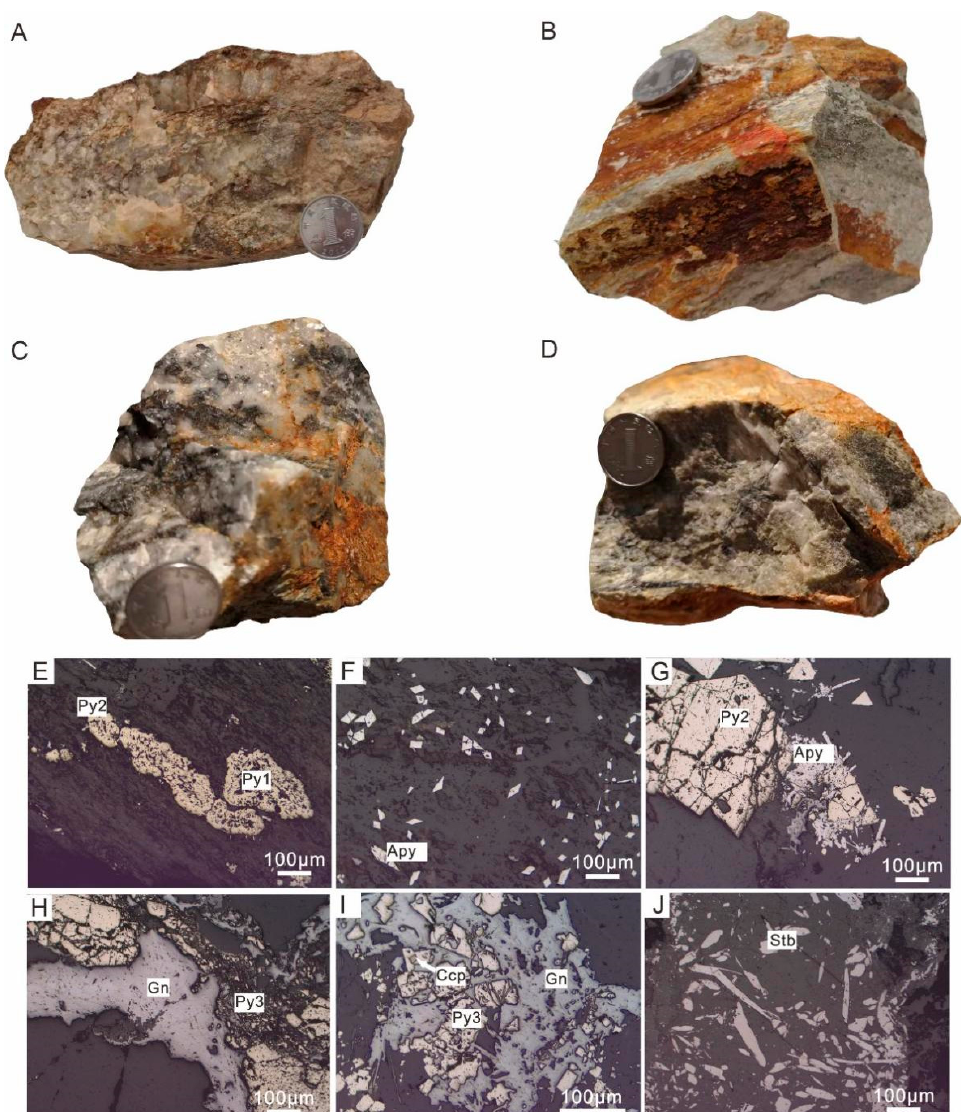
Figure 4. Photos of the ore of each stage and micrographs showing paragenesis associations in the Hongqigou deposit. ( A ) Typical barren quartz of stage 1; ( B ) Typical quartz–pyrite–arsenopyrite– chalcopyrite ore of stage 2; ( C ) Typical quartz–galena–pyrite ± arsenopyrite ore of stage 3, which represent the major lead, zinc, and silver metallogenic period; ( D ) Typical quartz–stibnite–carbonate ore of stage 4; ( E ) Rough and porous Py1 was contained by smooth Py2; ( F ) Arsenopyrite spread in stage 2 ores; ( G ) Euhedral–subhedral Py2 was crosscut by arsenopyrite in stage 2; ( H ) Subhedral Py3 was altered by galena; ( I ) Subhedral Py3 was interfilled by galena and chalcopyrite; ( J ) Stibnite spread in quartz-stibnite-carbonate ores in stage 4. Abbreviations: Apy = arsenopyrite, Ccp = chalcopyrite, Gn = galena, Py = pyrite, Stb = stibnite.